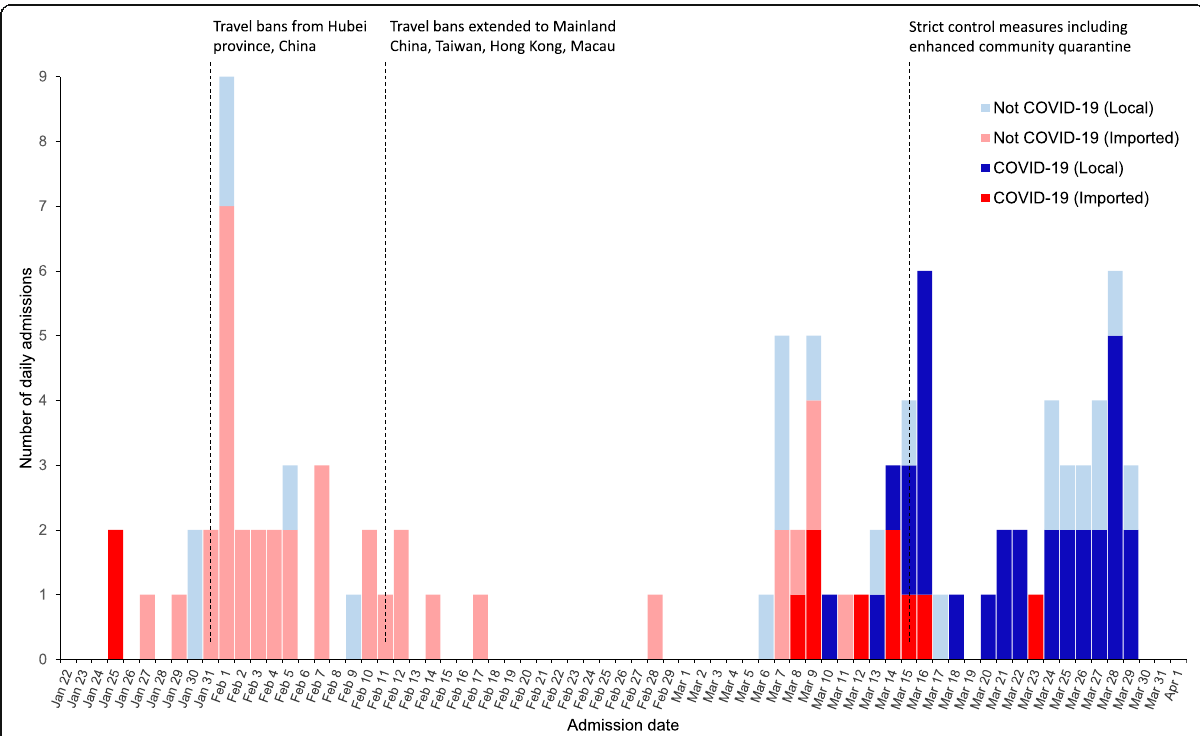
Fig. 1 Timeline of admission date of the first 100 suspected COVID-19 cases to an infectious diseases hospital in Metro Manila. Cases were considered “ imported ” if a history of international travel was reported within 14 days prior to the admission, and conversely ‘ local ’ if no international travel was reported within 14 days prior to the